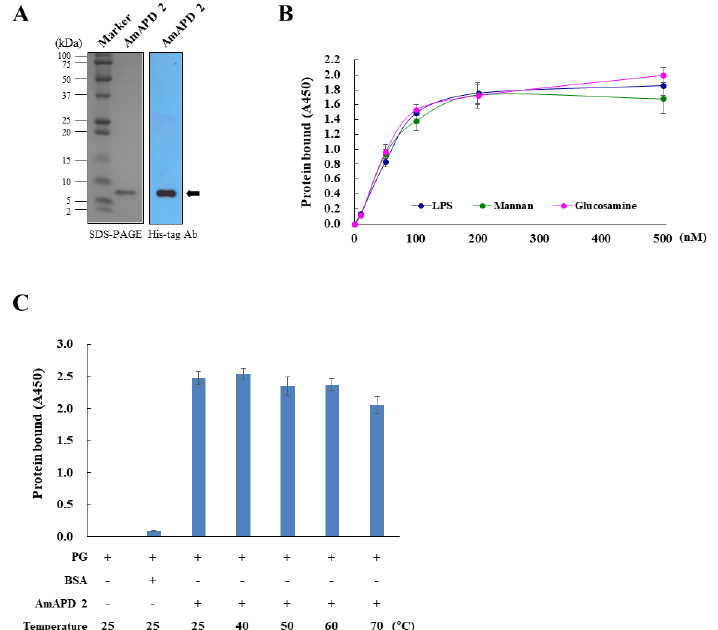
Figure 3. Carbohydrate-binding of recombinant Apis mellifera apidermin 2 (AmAPD 2). ( A ) Production of recombinant AmAPD 2 in baculovirus-infected Sf9 insect cells. The purified recombinant AmAPD 2 was verified via 12% sodium dodecyl sulfate-polyacrylamide gel electrophoresis (SDS-PAGE, left), followed by western blot analysis using an anti-His-tag antibody (right). The molecular weight standard and recombinant AmAPD 2 are indicated. ( B ) Binding of recombinant AmAPD 2 to lipopolysaccharide (LPS), mannan, and N -acetyl-D-glucosamine ( n = 3). ( C ) Binding of heat-treated recombinant AmAPD 2 to peptidoglycan (PG) ( n = 3). Recombinant AmAPD 2 was preincubated at 40 °C–70 °C for 1 h. We performed a microbial binding assay using the recombinant AmAPD 2 against the live bacteria and fungi used in several of our previous studies [20–23]. The microbial binding assay using western blot analysis revealed that the recombinant AmAPD 2 binds to E. coli , B. thuringiensis , and B. bassiana (Figure 4A). We also found that recombinant AmAPD 2 heat treated at 50 °C for 1 h still bound to B. thuringiensis (Figure 4A). Moreo- ver, we observed the localization of the recombinant AmAPD 2 on the microbial surfaces using immunofluorescent staining (Figure 4B).